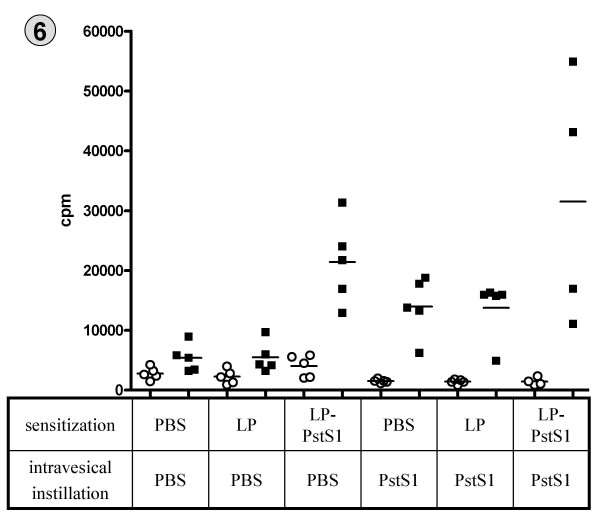
Splenocyte Restimulation. Treatment of mice was performed as indicated (s.c. sensitization / intravesical instillation). One day after the fourth intravesical PstS1 treatment splenocytes were isolated and restimulated with PBS as control (open circles) or 10 μg/ml PstS1 (filled boxes) for five days and proliferation was analyzed by 3H-Thymidine incorporation assay.